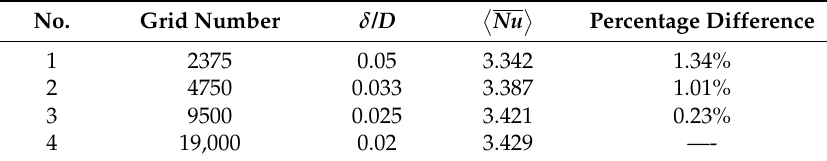
Table 1. The grid study at Re = 100, S/D = 1.5, d p = 30 nm, and Φ = 0.01.